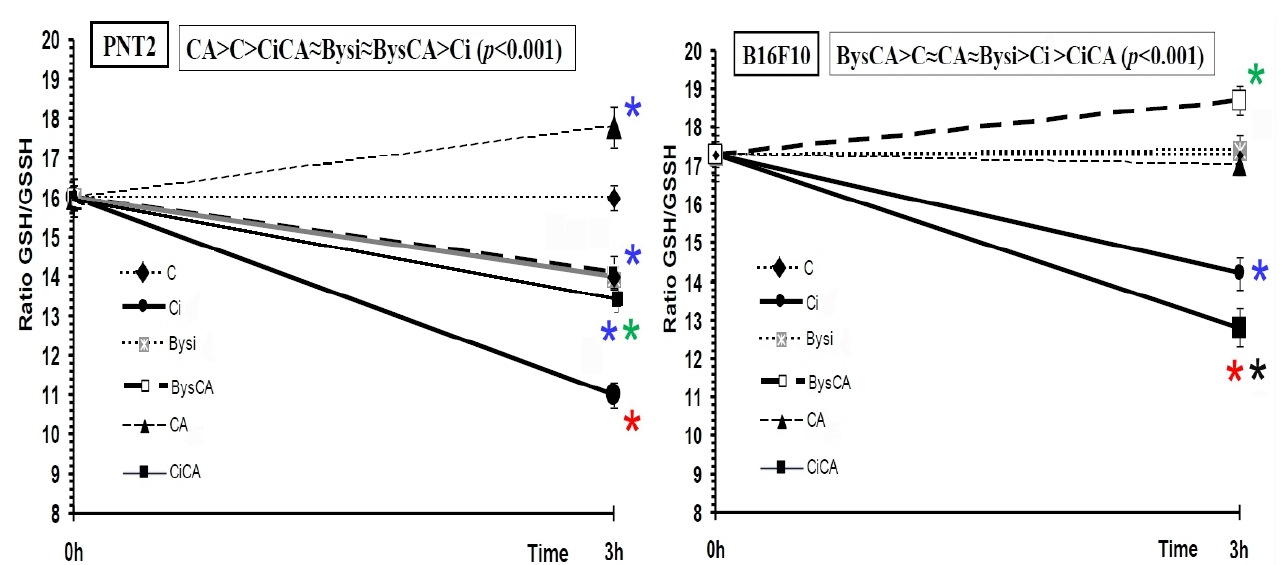
Figure 10. GSH/GSSG ratios of the different groups studied (C, control; CA, treated with carnosic acid; Ci, irradiated control; CiCA, irradiated previously treated with carnosic acid; Bysi, treated with previously irradiated serum; BysCA, treated with irradiated serum previously treated with carnosic acid) (* p < 0.001 versus C; * p < 0.01 versus C; * p < 0.01 versus Ci; * p < 0.05 versus Ci). Data are mean ± SE of six independent experiments.